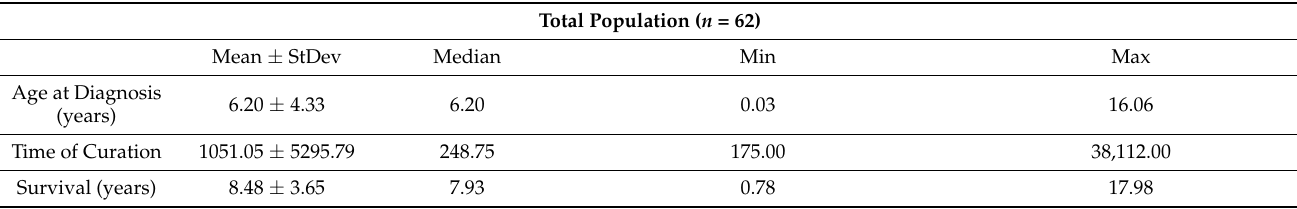
Table 1. Demographic and clinical characteristics of the study population (Legend: StDev: Standard deviation, ATRT: Atypical teratoid rhabdoid tumor, CR: Clinical